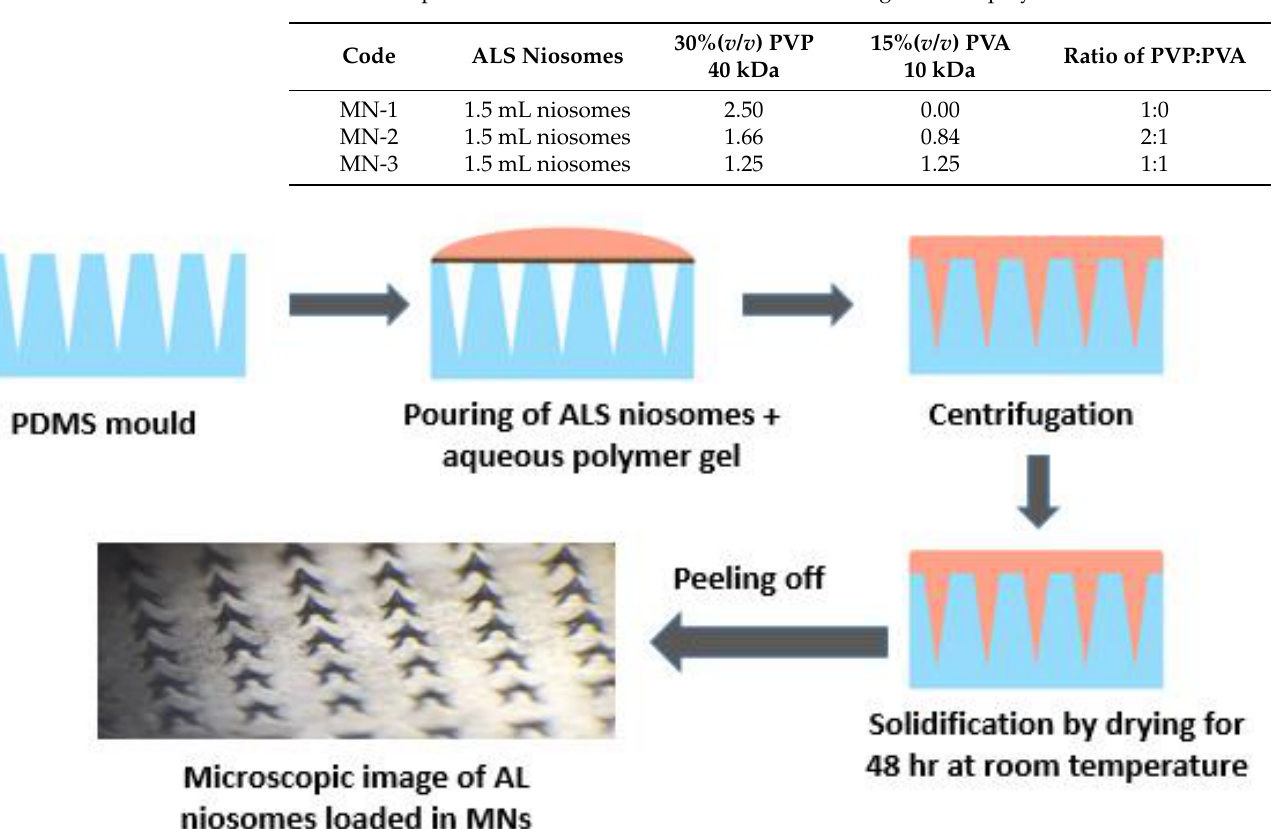
Table 2. Composition of ALS-loaded niosomes in MNs using different polymers PVP and PVA.